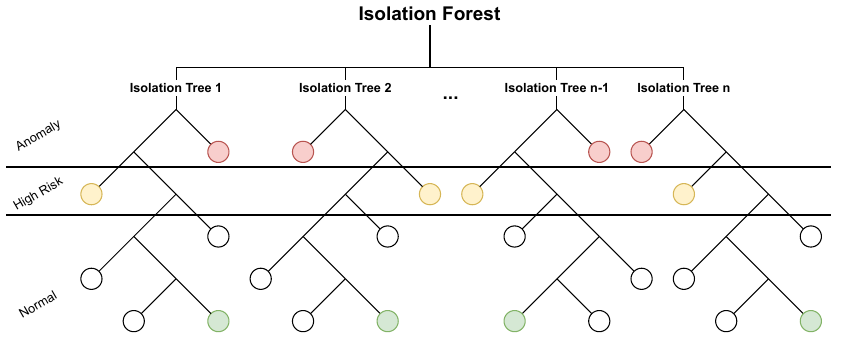
Figure 3. Sketch of anomaly detection with IF.